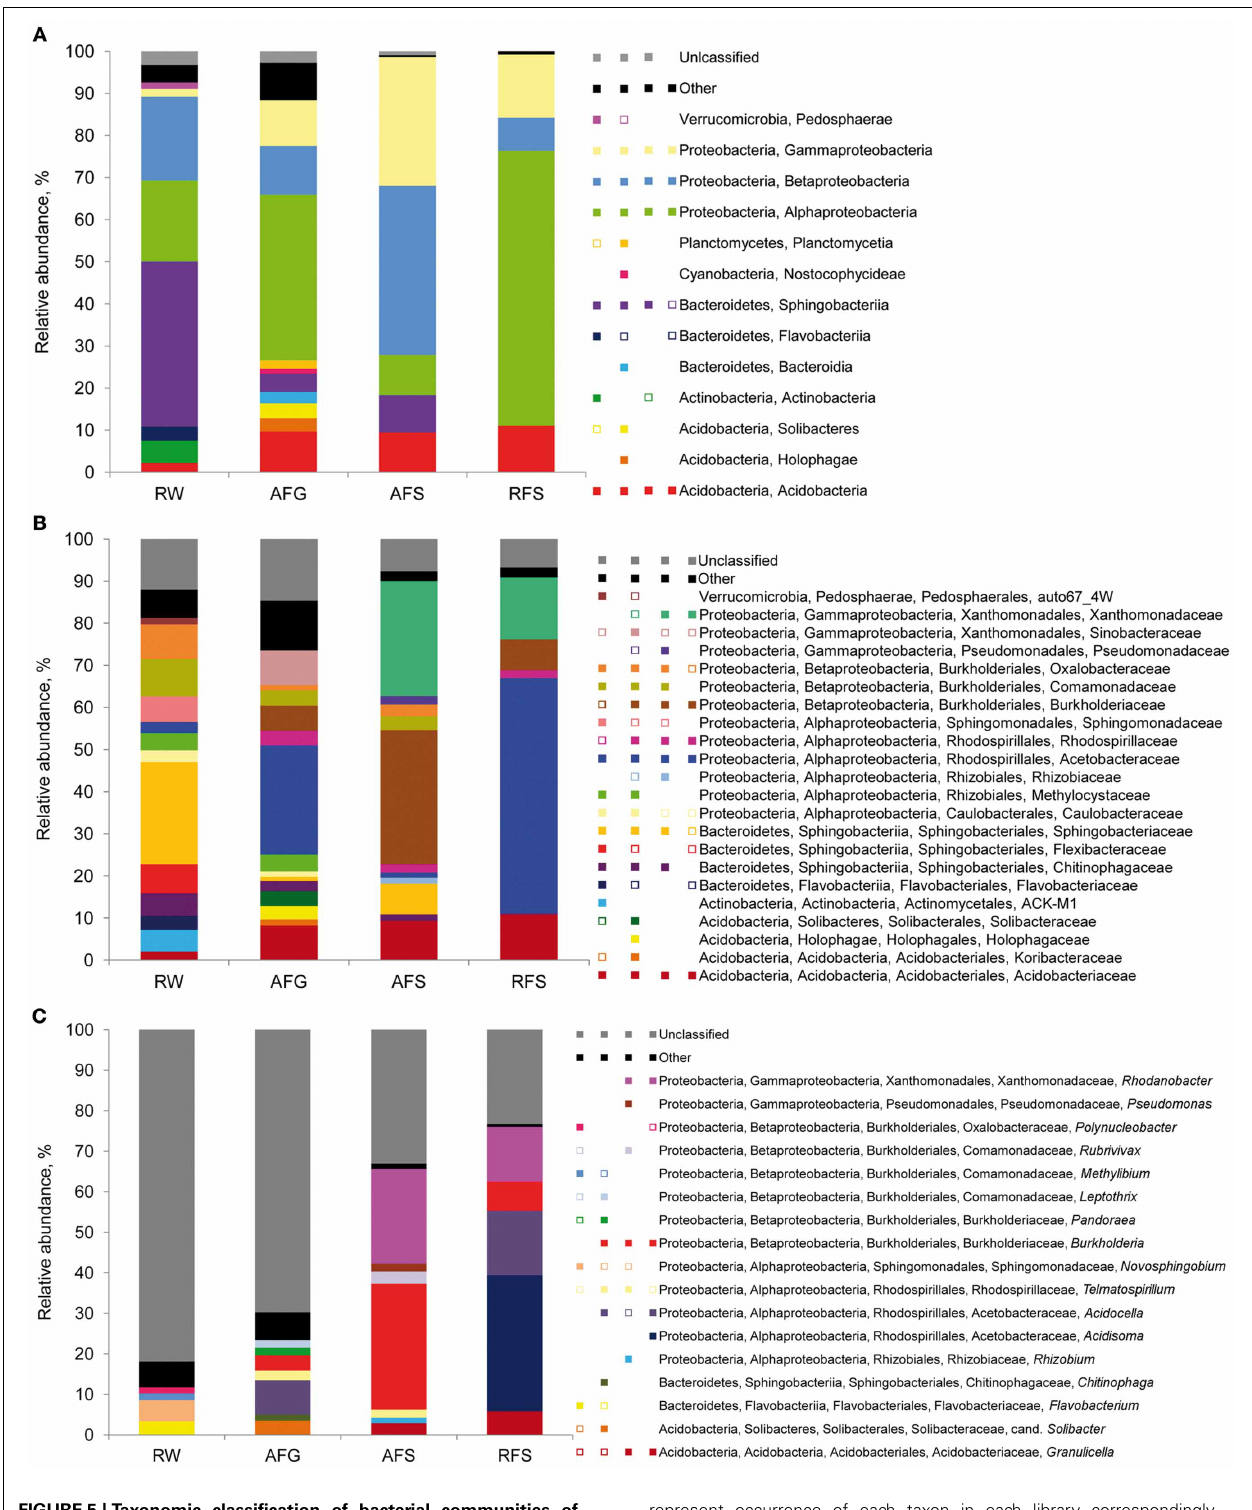
represent occurrence of each taxon in each library correspondingly. Taxons below 1% of relative abundance are included in ‘Other’ and depicted as empty squares on the multi-colored charts. Abbreviations: A, Austria; R, Russia; W, flark water; F, S. fallax ; G, gametophyte, S,